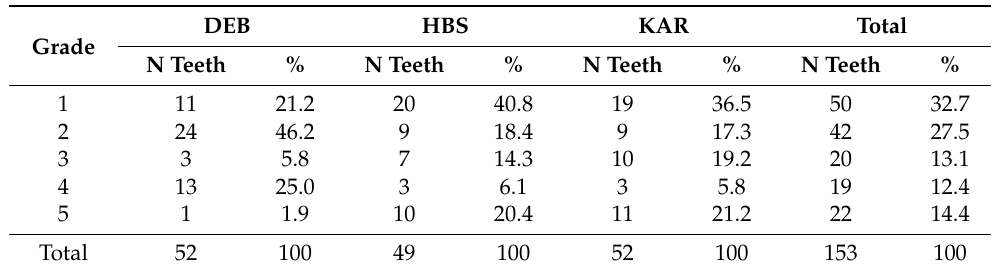
Table 6. Degree of caries in adult individuals: number of affected teeth (N teeth) by severity of carious lesion (grade